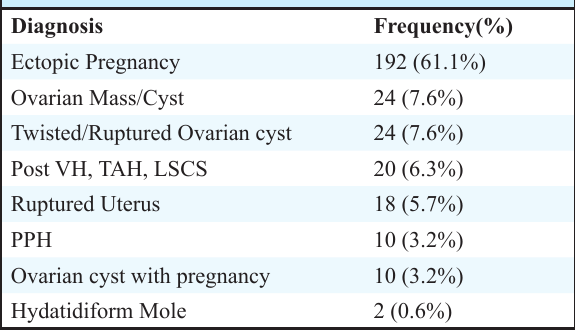
Table 2. Diagnosis of the patients at the emergency room.